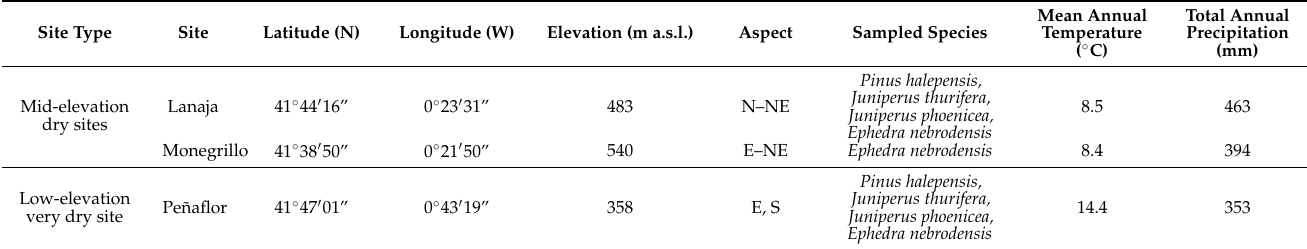
Figure 1. Views of the study species (( a ) Pinus halepensis , ( b ) Juniperus thurifera , ( c ) Juniperus phoenicea , and ( d ) Ephedra nebrodensis ); climate diagrams of Lanaja ( e ), Monegrillo ( f ), and Peñaflor ( g ) meteorological stations; ( h ) cross-section of Ephedra wood sampled from an individual located in the Lanaja site. The blue and red numbers indicate wide and narrow annual rings, respectively, situated along the cross-section, which corresponded to wet and dry conditions, respectively. Note the vessels with the small lumen area in the very wide 1997 ring. Table 1. Climate characteristics of the three study sites and sampled tree and shrub species. See Figure 1 for additional climatic